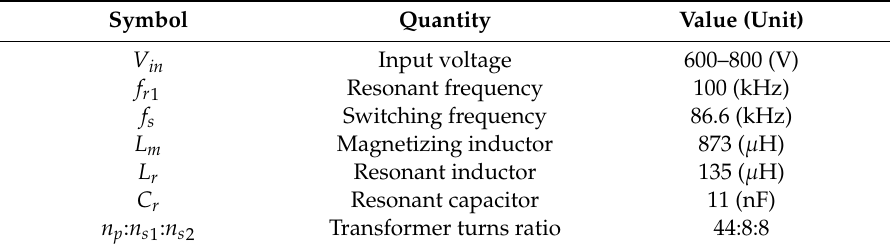
Table 1. Component parameters of the test setup.